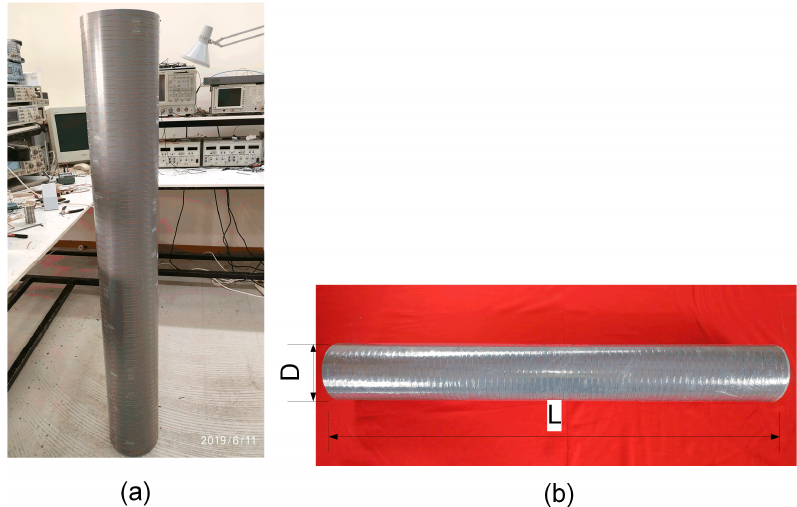
Figure 3. ( a ) The constructed coil (solenoid); ( b ) coil dimensions: length L is 150 cm, diameter D is 20 cm.